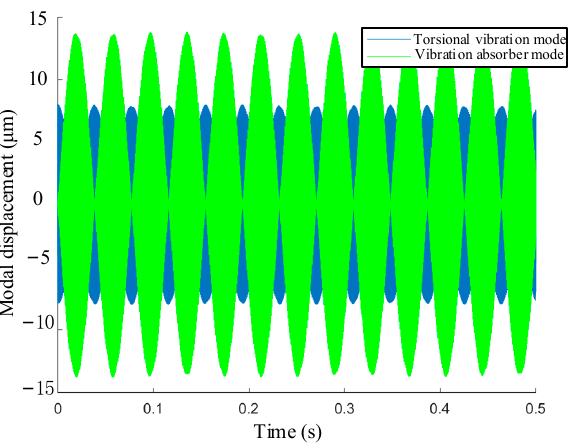
Figure 4. Two modes’ vibration displacement (initial excitation).